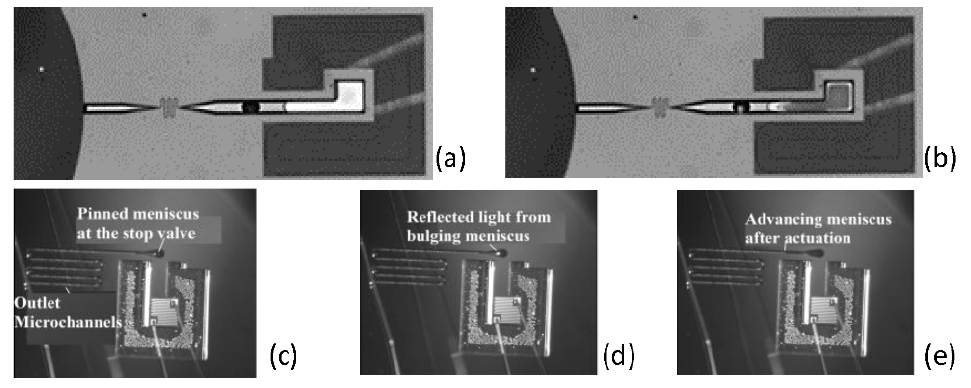
Figure 3. Glass side view ( a ) before and ( b ) after thermal actuation. The displacement of the meniscus is clearly visible. Silicon side view ( c ) before actuation, ( d ) during actuation with bulging meniscus and ( e ) after